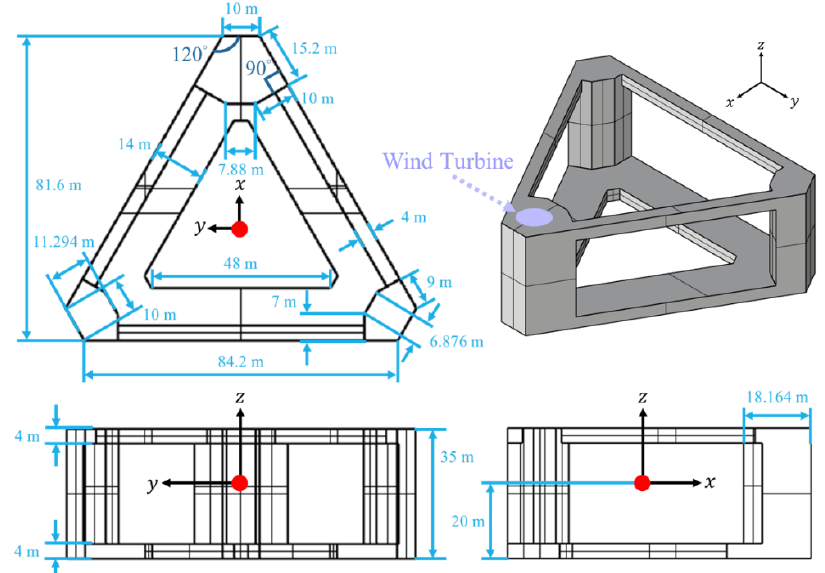
Figure 1. Dimensions of Taida platform.